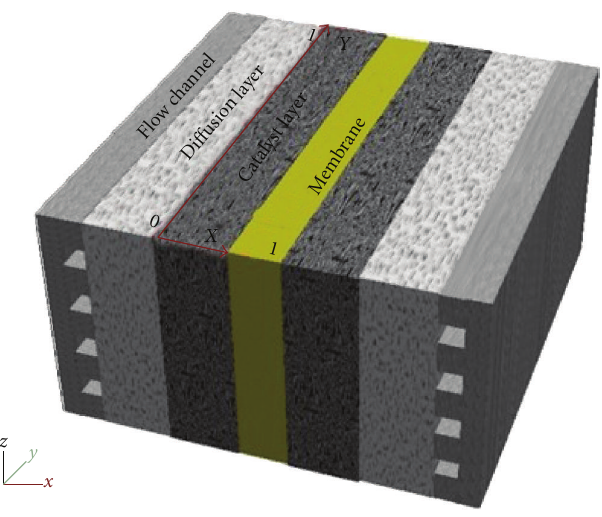
Figure 1: The schematic view of the modeling domain.